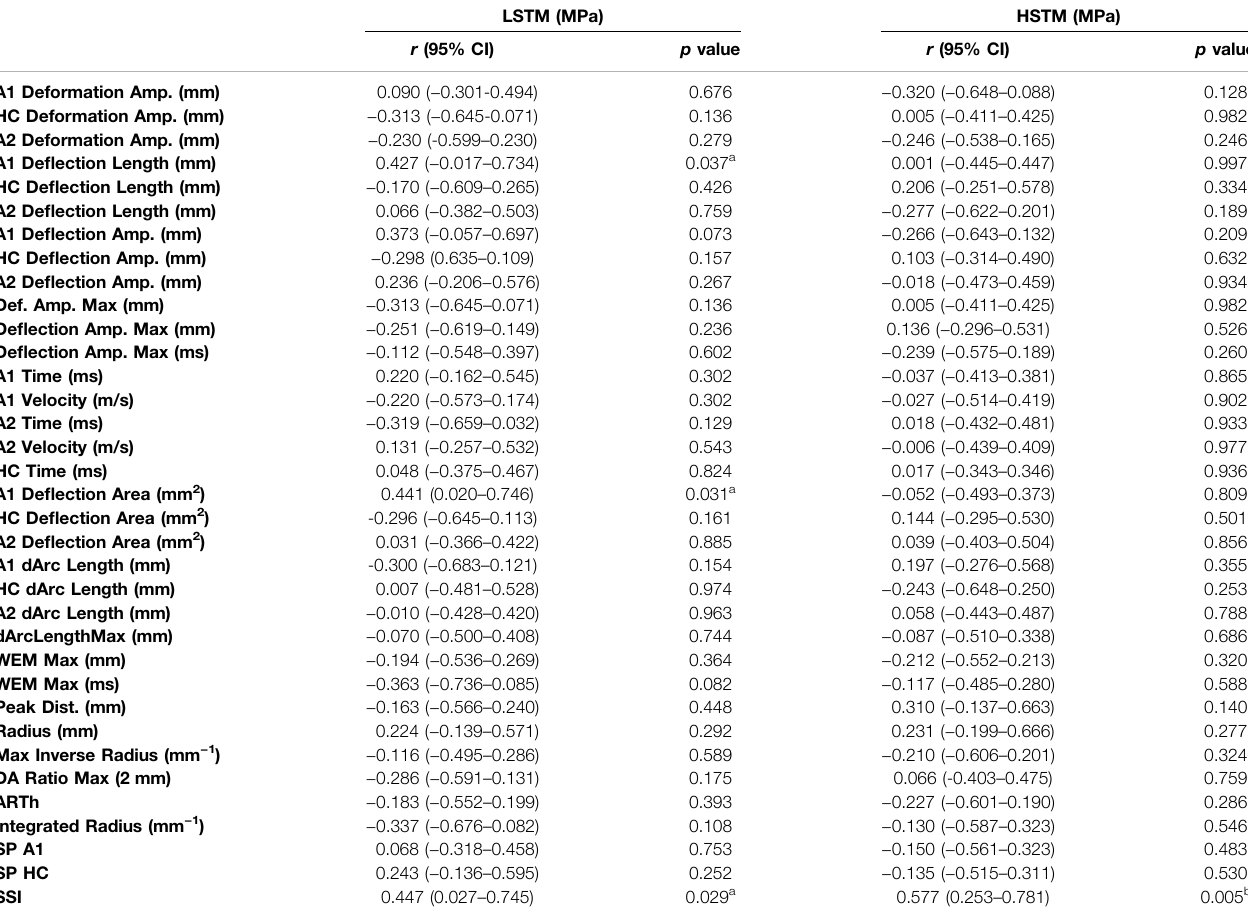
TABLE 3 | Correlation between Young ’ s modulus and CorVis ST corneal dynamic response and stiffness parameters ( n = 24). LSTM